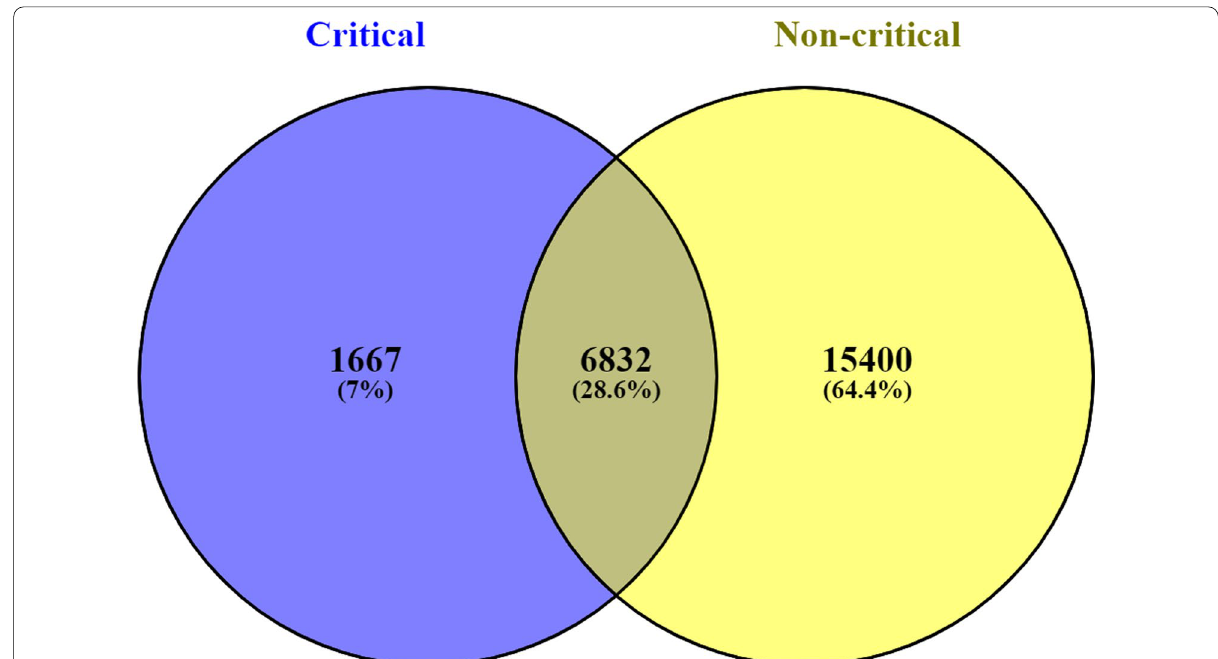
Fig. 3 Venn diagram showing variants overlap between critical and non-critical patients’ cohorts. The “blue” color represents critical patients, and the “yellow” color represents non-critical patients. The critical patients had 1667 (7%) of the total unique variants, while non-critical individuals had 15,400 (64.4%) unique variants. There were 6832 (28.6%) common variants between the critical and non-critical patient